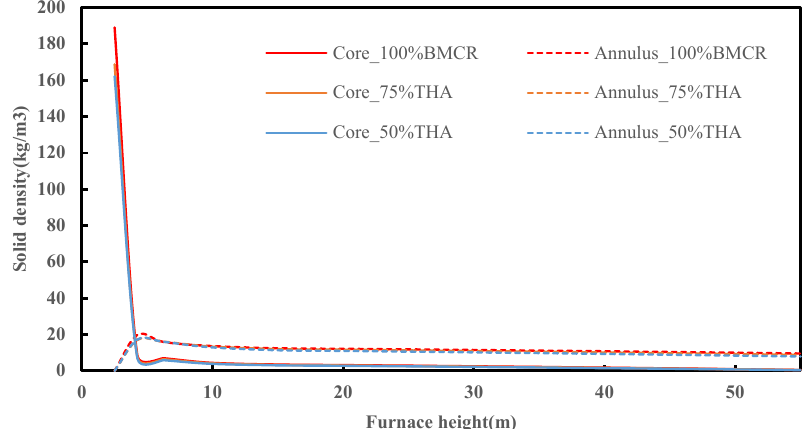
Figure 4. Solid density distribution of core and annulus area in furnace at different